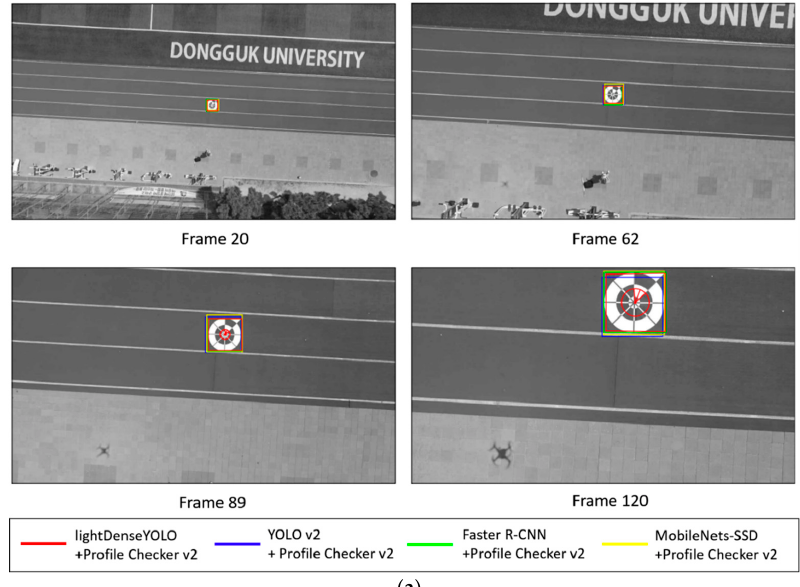
Figure 20. Comparison of predicted direction error (PDE) close distance images of various